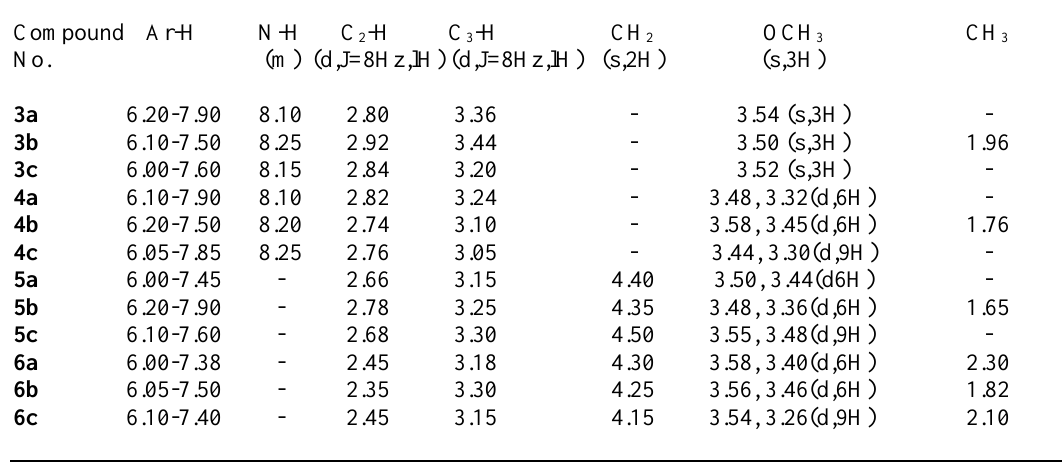
Table 3. The 1 H NMR spectral data of 1,5-benzothiazepine derivatives in d